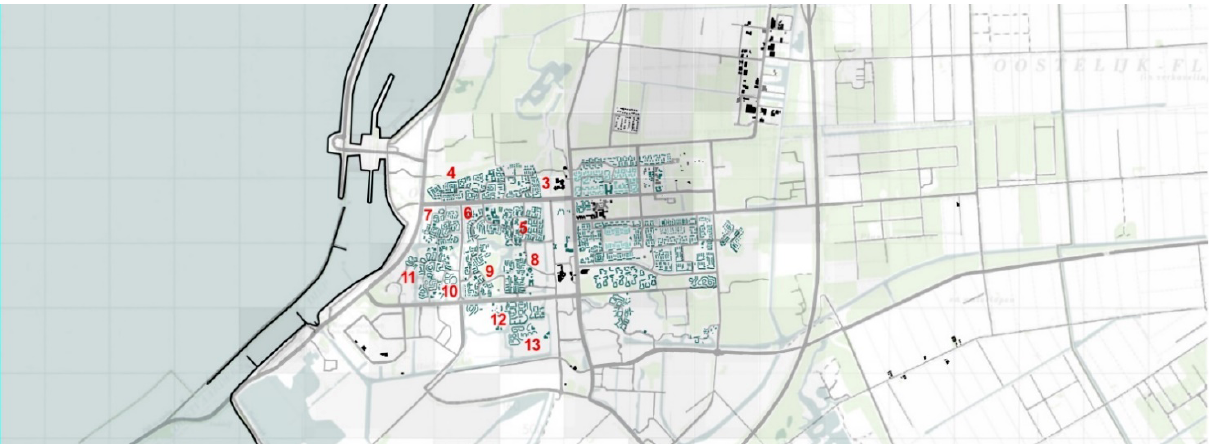
Figure 19. Neighbourhoods that were built between 1970 and 1980. Notes: (3) Karveel, (4) Boeier, (5) Kempenaar, (6) Kogge, (7) Punter, (8) Schouw, (9) Gondel, (10) Jol, (11) Galjoen, (12) Boswijk (phase 1) and (13) Tjalk. Source: authors.